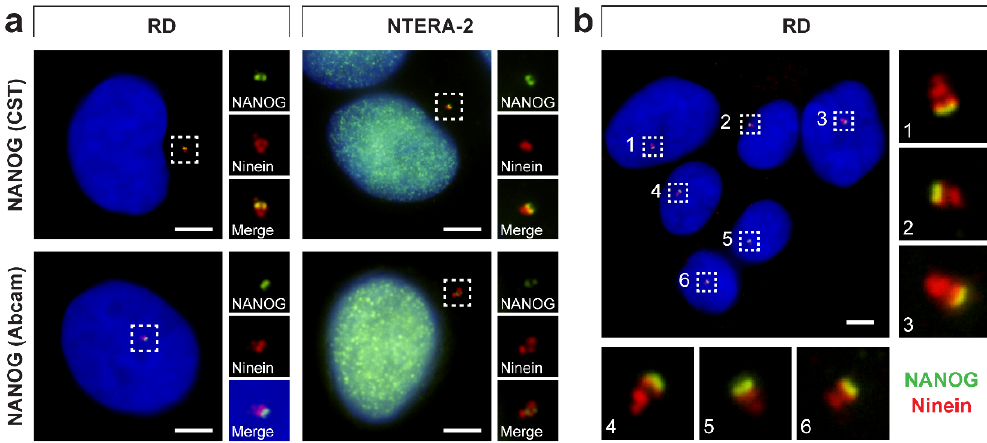
Figure 9. NANOG colocalization with the mother centriole. ( a ) A colocalization of NANOG (green; #4903, Cell Signaling Technology (CST) and #ab109250, Abcam) with the mother centriole was detected using anti-ninein antibody (red), recognizing a protein of the mother centriole subdistal appendages. The nuclei were counterstained with Hoechst 33342 (blue). For each image, regions of interest and the respective close-ups are indicated by the dashed boxes. ( b ) NANOG signal (green; #4903, Cell Signaling Technology) partially colocalized with the “double-spot” signal of ninein (red). The nuclei were counterstained with Hoechst 33342 (blue). Respective close-ups of NANOG and ninein colocalization are indicated by numbers. Scale bars, 5 μ m.